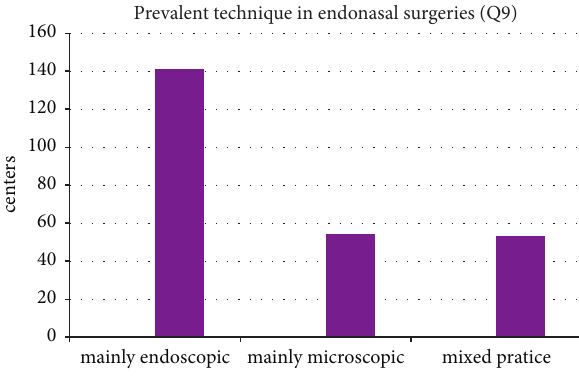
Figure 3: Techniques used for endonasal